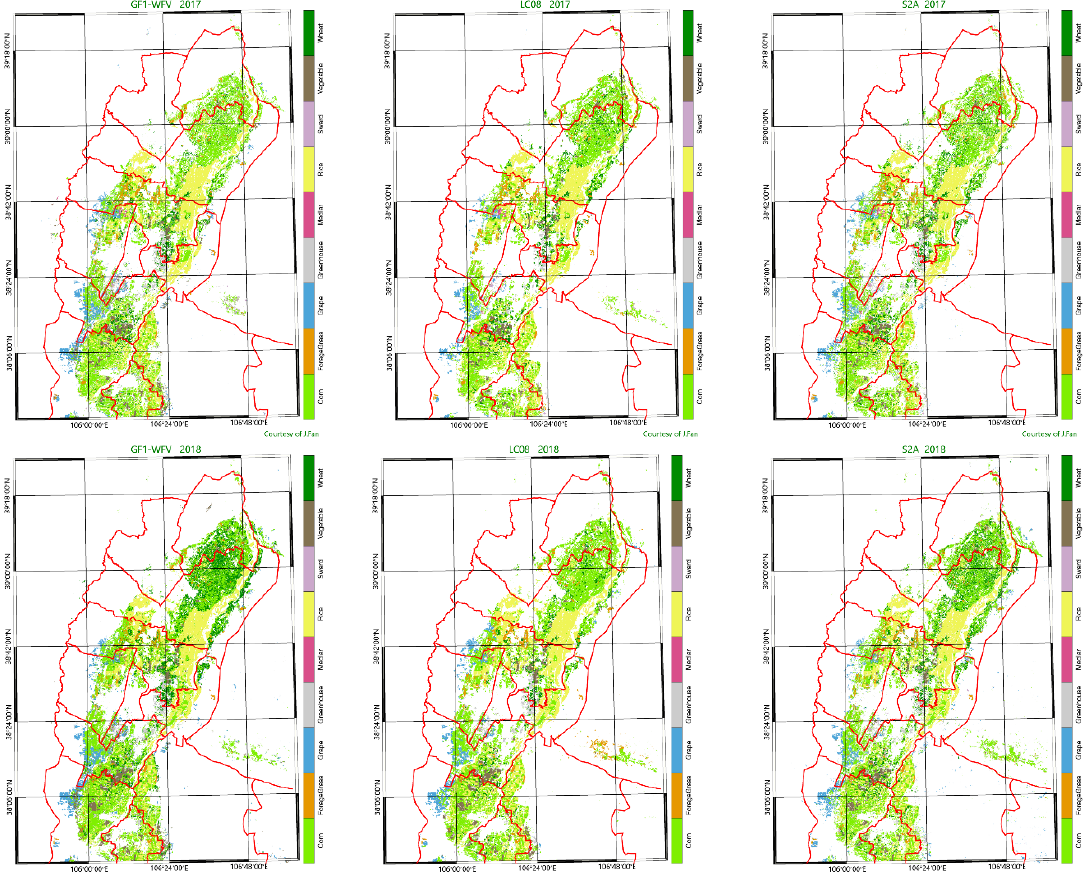
Figure 6. The full capability of crop type map of three satellite data sources.